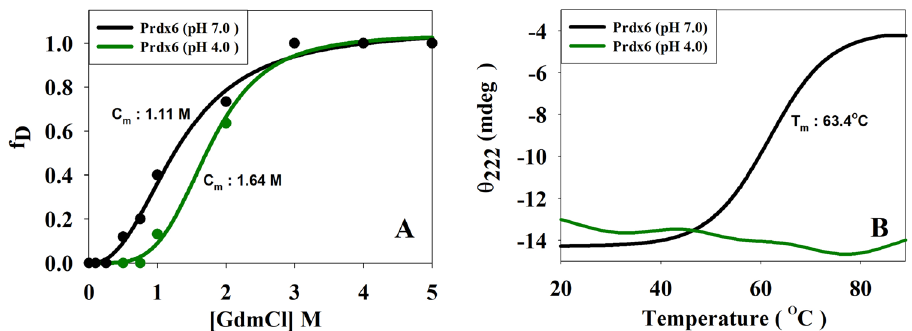
Figure 1. Stability of hPrdx6. The effect of cytosolic (pH 7.0) to lysosomal (pH 4.0) switching on the ( A ) thermal* and ( B ) chemical stability of hPrdx6 is determined using Far-UV CD spectroscopy. (Tm/pH7: 63.37 °C) (Cm/pH7: 1.11 M; pH4: 1.64